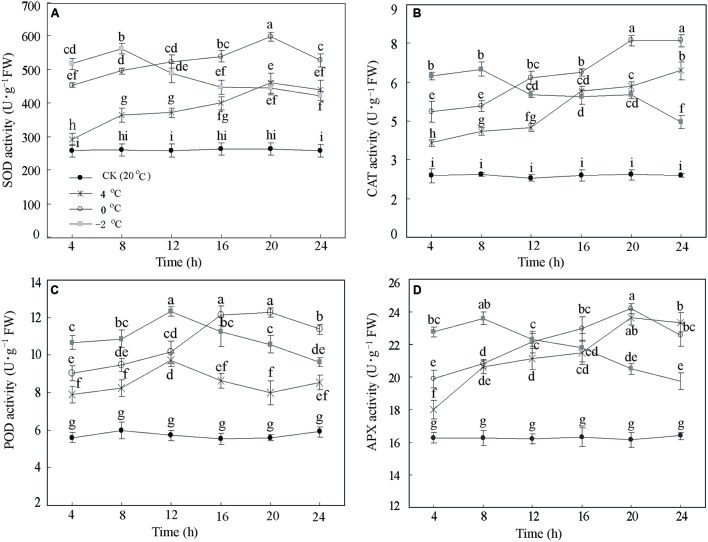
Antioxidant enzymes responses of Dendrobium officinale to cold acclimation. The activities of (A) superoxide dismutase (SOD) activity, (B) catalase (CAT) activity, (C) peroxidase (POD) activity, and (D) ascorbate peroxidase (APX) were quantified by the means of three independent experiments ± SD. Different letters mark indicates significantly different at P < 0.01.